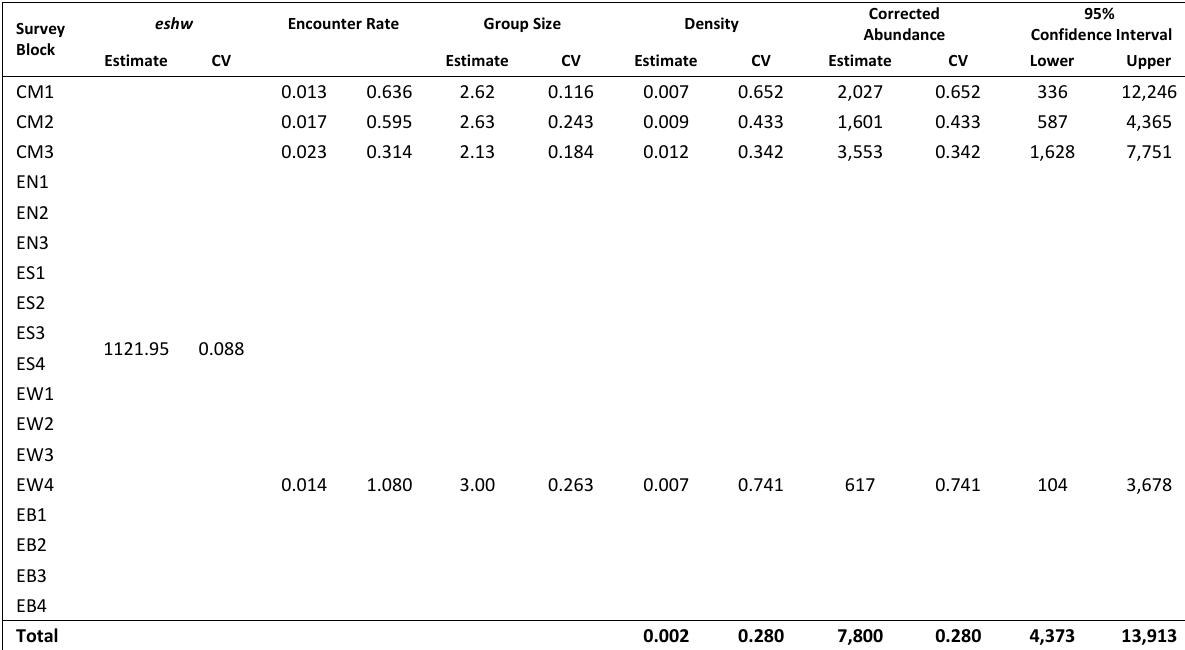
Table 12. Estimated density and abundance of northern bottlenose whales . The eshw (effective search half width (m)) was estimated for the entire study area. Encounter rate, group size, density, abundance, and upper and lower confidence limits were estimated by block and corrected for perception bias, with the estimated p